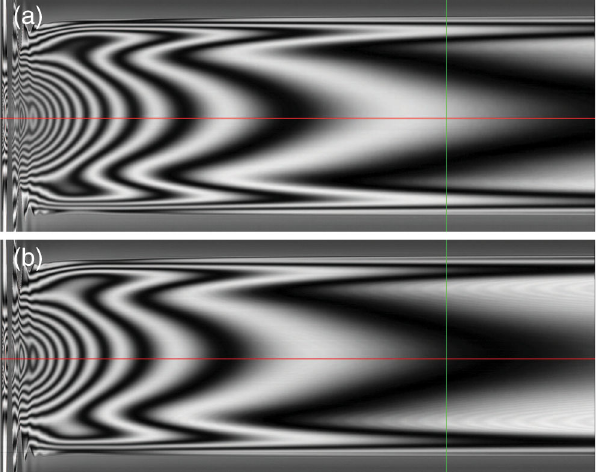
FIG. 5. A typical example of intensity along one fixed line (vertical axis) with respect to time (horizontal axis), for λ ¼ 434 nm (a) and 546 nm